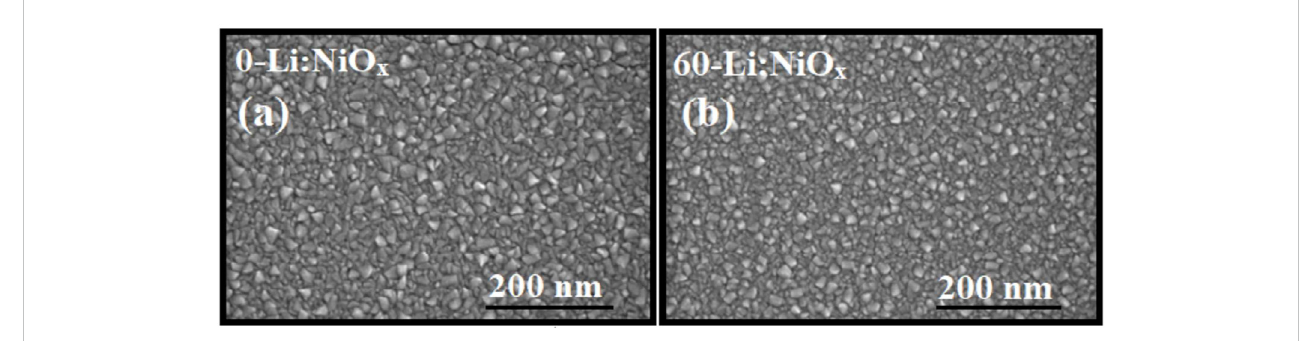
FIGURE 4 SEM images for (A) 0-Li:NiO x and (B) 60-Li:NiO x thin fi lms deposited at 400 ° C using methanol-based precursor on borosilicate glass substrate.